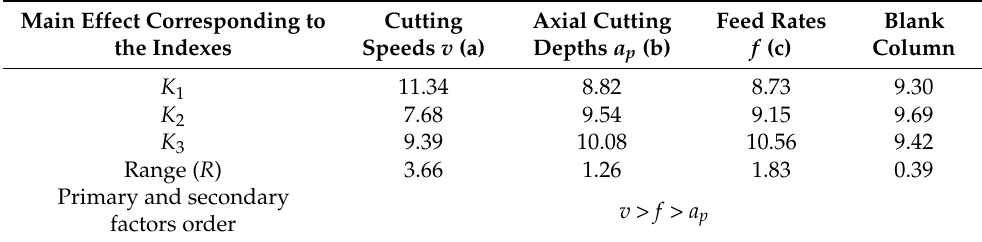
Table 5. S a range calculation of orthogonal